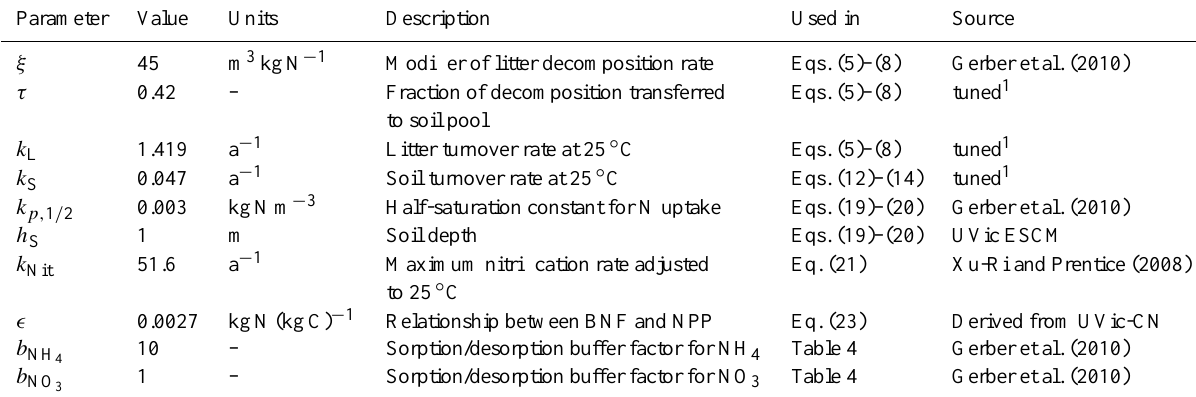
Table 3. List of parameters used in the UVic-CN model that are either new or have changed values.